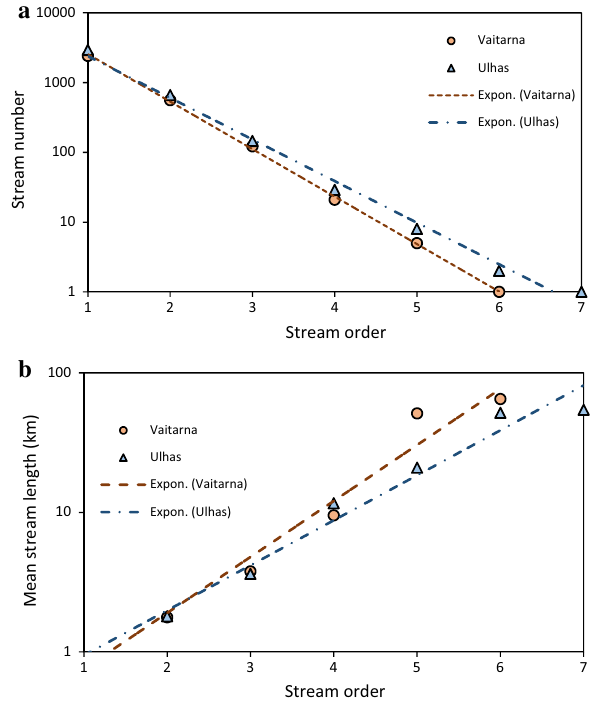
Fig. 4 a Scatterplot is showing the relationship between stream order and stream number. b The relationship between stream order and mean stream length